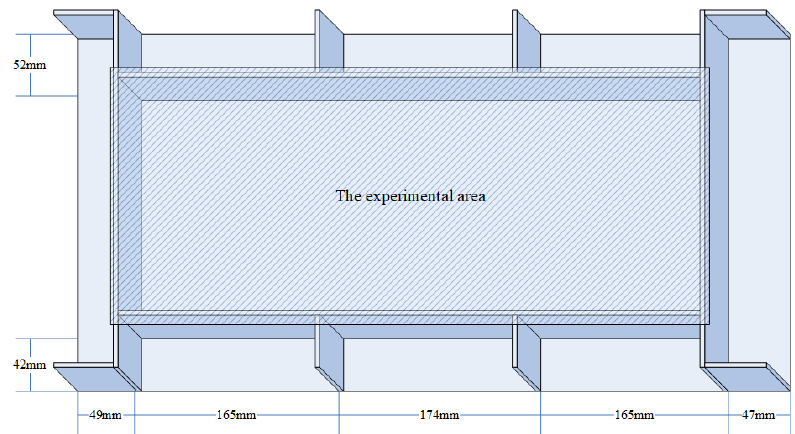
Figure 2. The fixation of the composite laminate on the tank surface.